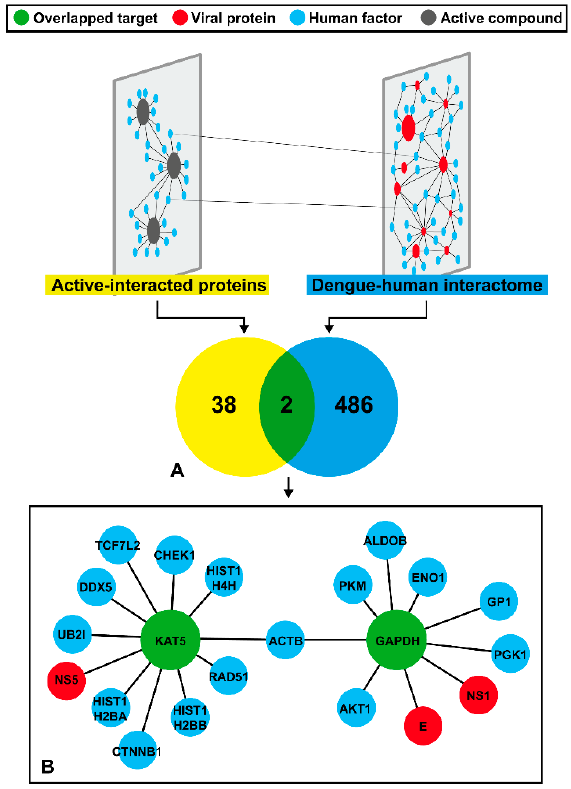
Figure 4. Result of the DENV-related target prediction and neighboring proteins using the network-based screening techniques. ( A ) Possible targets correlated to DENV viral infection derived from the overlap between similar compound’s targets and proteins in the DenvIntS PPI network. ( B ) The sub-network of two predicted targets (KAT5 and GAPDH) and neighboring proteins obtained from DenvIntS network.